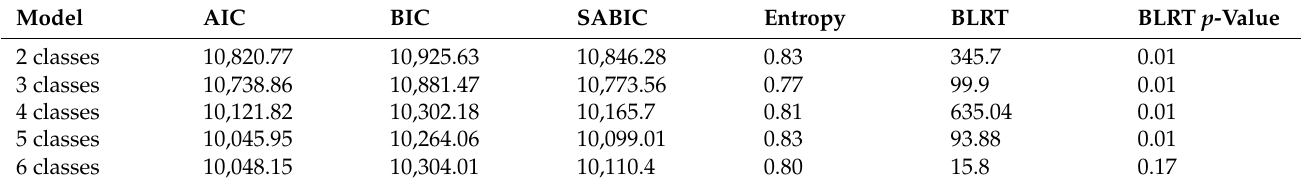
Table 3. Fit indices for the models examined with latent profile analysis.